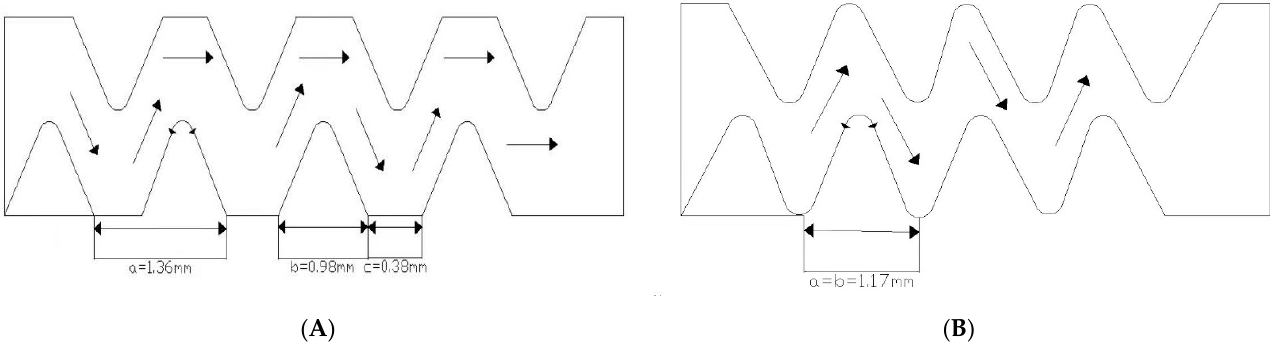
Figure 5. The structure diagram of the two drip irrigation channel types. The arrow represents the size of the parameters. ( A ) Flow channel 1 (with a tooth base). ( B ) Flow channel 2 (without a tooth base).